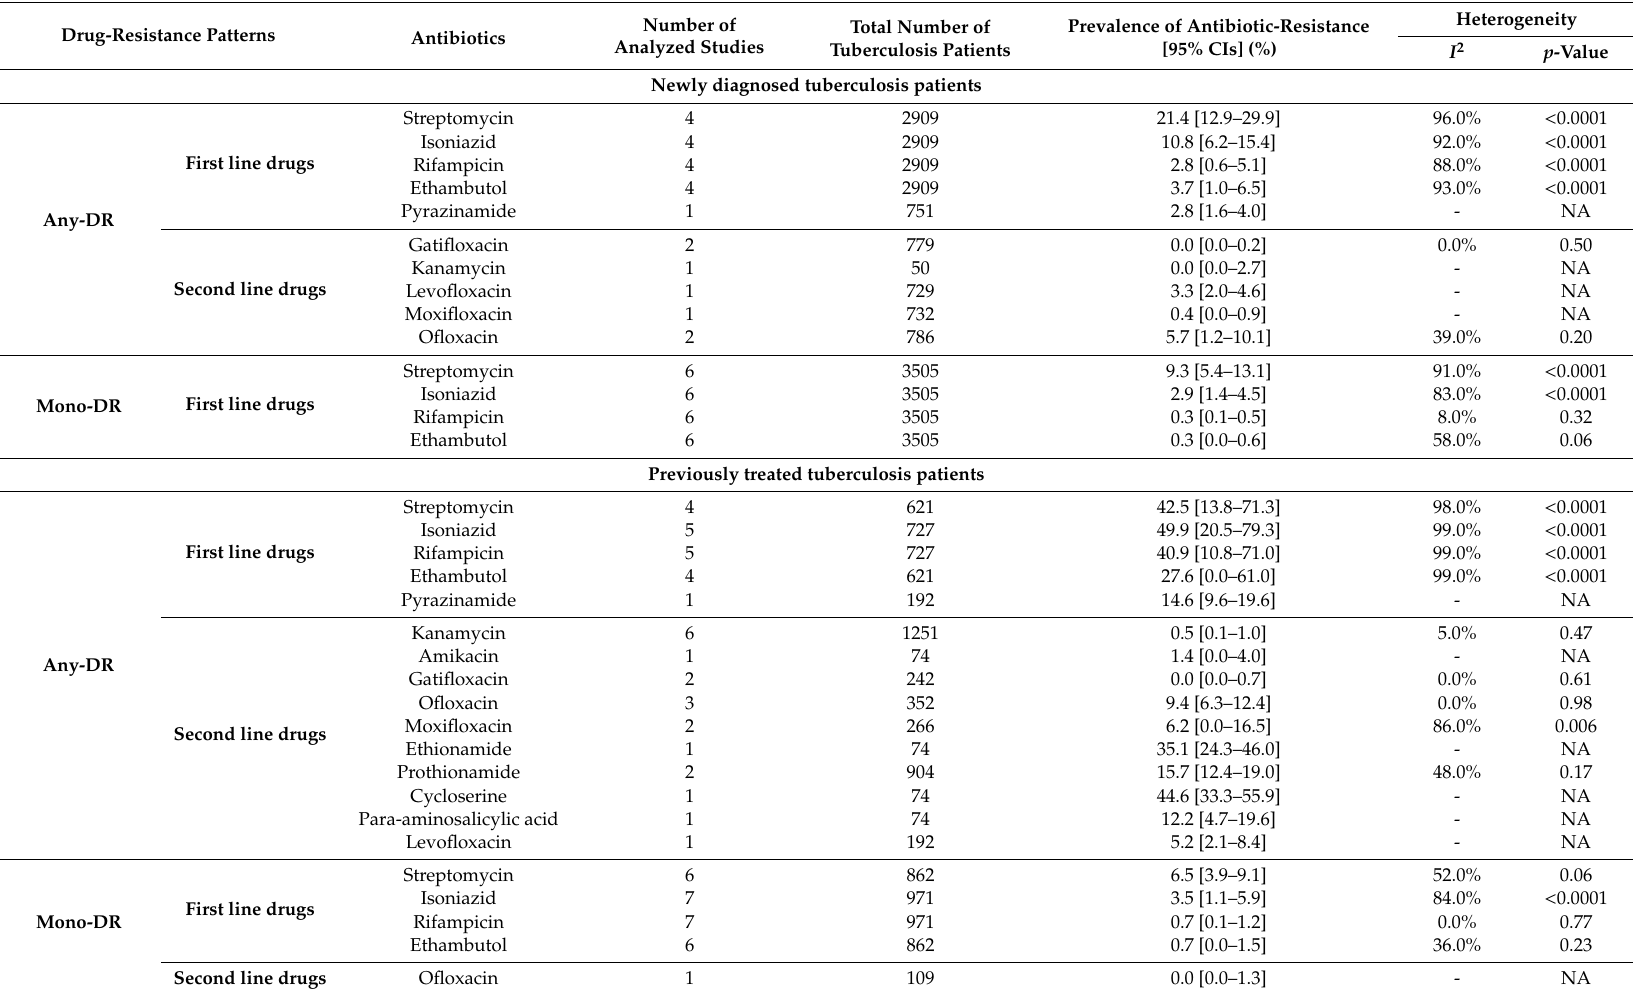
Table 3. Anti-tuberculosis-DR patterns in newly diagnosed and previously diagnosed tuberculosis